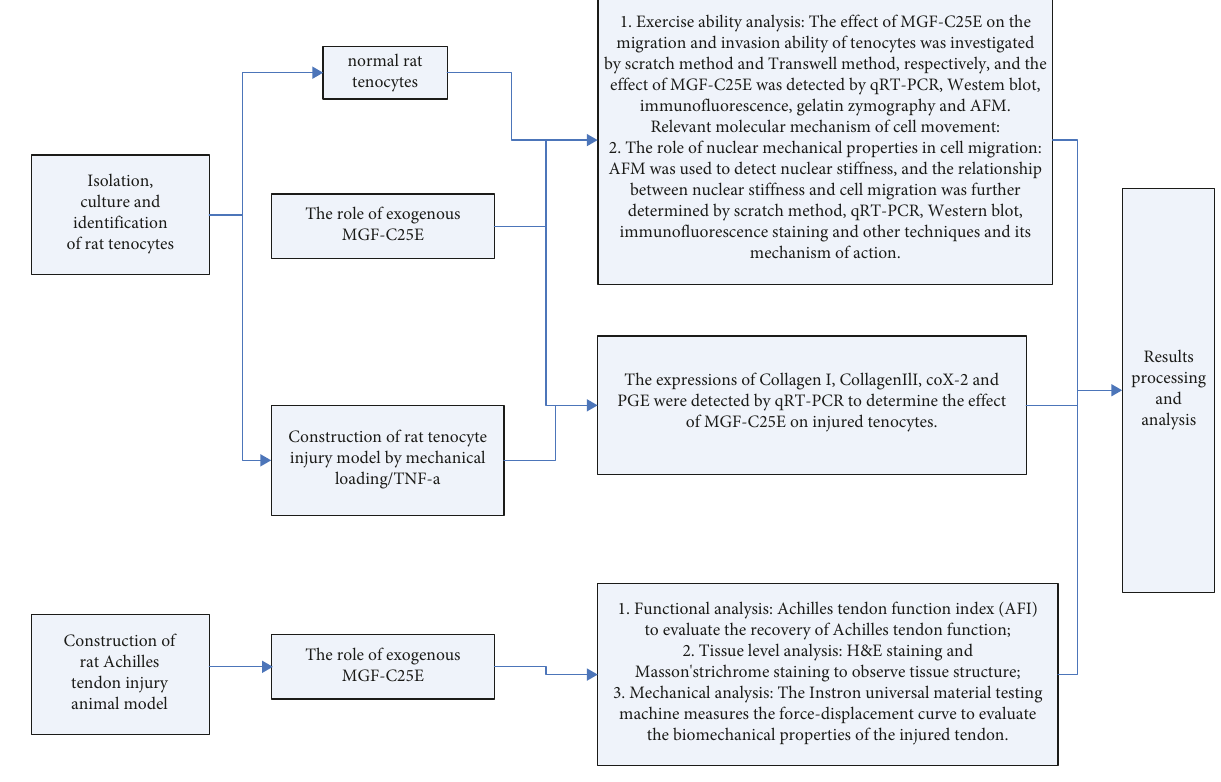
Figure 5: Technology